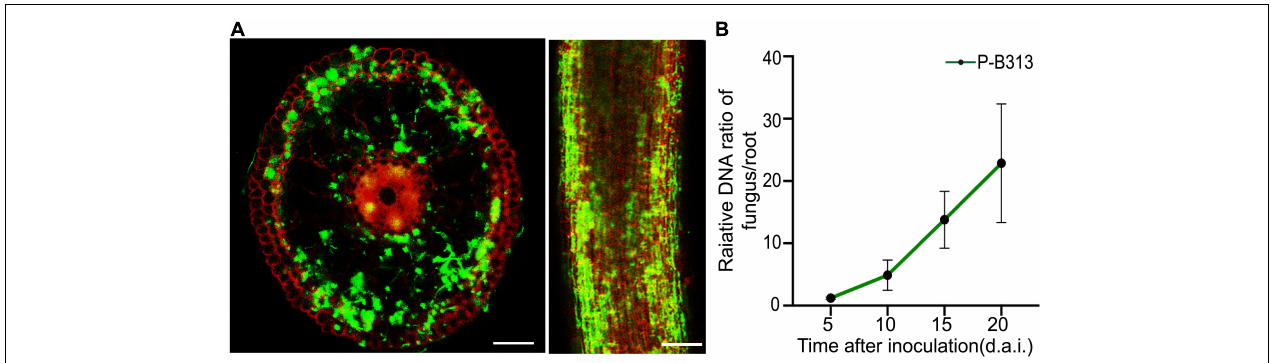
FIGURE 4 | Colonization pattern of P. oryzae in rice roots. (A) GFP-tagged hyphae gradually extended from the epidermis to the endodermis in a root cross-section and longitudinal section. Bar, 5 µ m. (B) Relative amounts of fungal DNA in rice roots at different time points (5, 10, 15, and 20 d.a.i.). A fungal colonization curve plotted with Mean ± SD is shown.